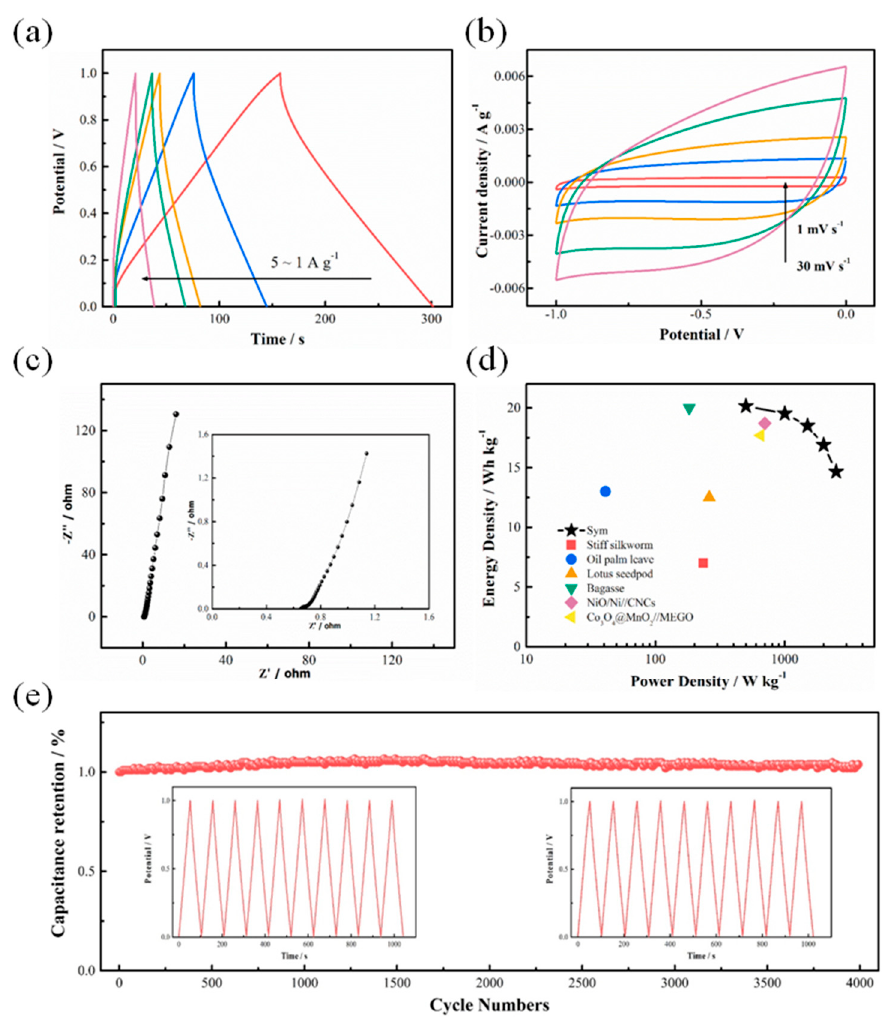
Figure 5. Electrochemical performances of corncob-derived carbon symmetric device: ( a ) GCD curves at current densities of 1, 2, 3, 4 and 5 A g − 1 ; ( b ) CV curves at different scan rates of 1, 5, 10, 20 and 30 mV s − 1 ; ( c ) Ragone plot (the inset shows the enlarged high frequency region); ( d ) Nyquist plots (energy density vs. power density); and ( e ) cycling test of corncob-derived carbon symmetric device in 2 A g − 1 ; 6 M KOH, inset is the GCD curves for the first and last ten cycles.